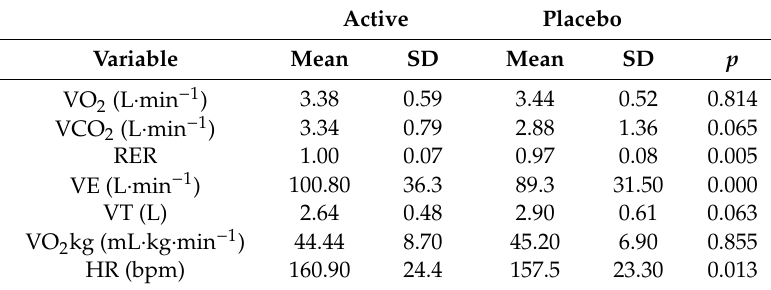
Table 7. Maximal test metabolic results.